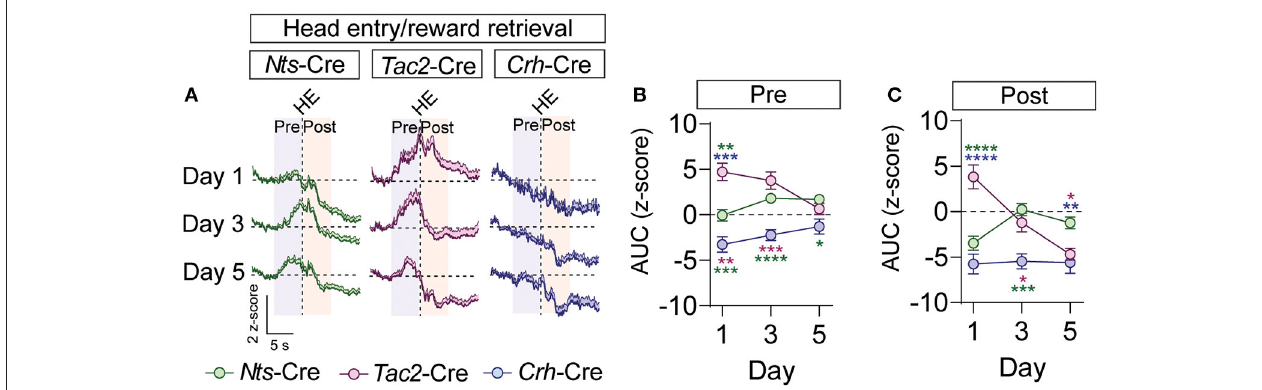
FIGURE 5 | GCaMP imaging of BNST → VTA axon terminals during reward retrieval in Nts-, Tac2-, and Crh -Cre mice. (A) Average z-score ( + SEM) of the 1 F/F of the GCaMP signal aligned to the first head entry into the food hopper following reward delivery for all trials from all mice for days 1, 3, and 5 of training. (B,C) Area under the curve of the z-score for the 5 second period prior to (B) or following (C) the head entry [ n = 7 Nts -Cre, 5 Tac2 -Cre, and 4 Crh -Cre mice, 2-way RM ANOVA Pre-HE Interaction F (4,39) = 5.825, P = 0.0009, Pre-HE Interaction F (4,39) = 11.77, P < 0.0001, Tukey’s multiple comparisons * P < 0.05, ** P < 0.01, *** P < 0.001, **** P < 0.0001]. Data are presented as mean ±